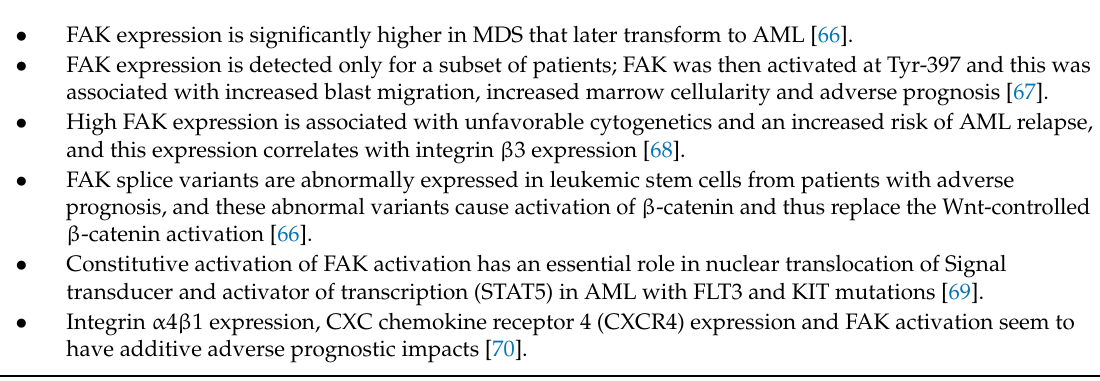
Table 3. The role of the non-receptor tyrosine kinase, focal adhesion kinase (FAK), in human